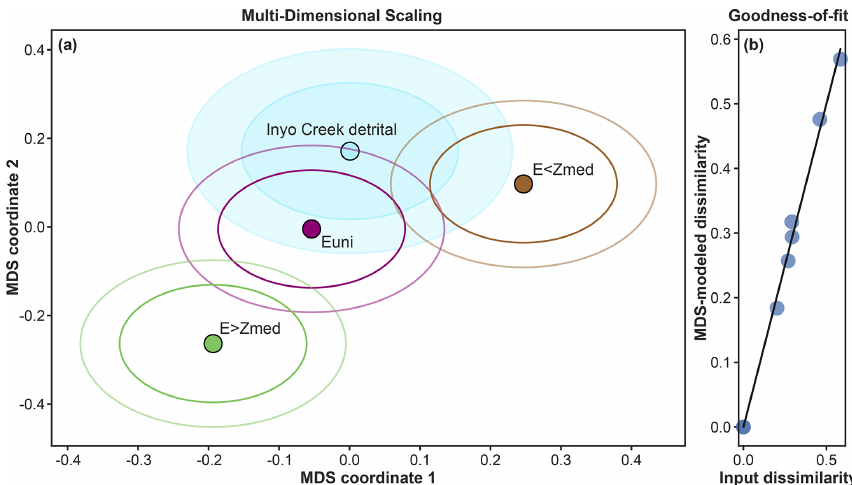
Figure 9. Multi-dimensional scaling (MDS) plot. The two-component MDS model fits a coordinate system to the measured dissimilarities (i.e., KS statistics) among all distributions. If the MDS model has a good fit, distances calculated in the new 2D space (a) are a good approximation of the input dissimilarities among the elements. The goodness of fit is shown in (b) , where modeled dissimilarities are plotted against input dissimilarities. For each distribution in (a) , 68% and 95% confidence ellipses are also